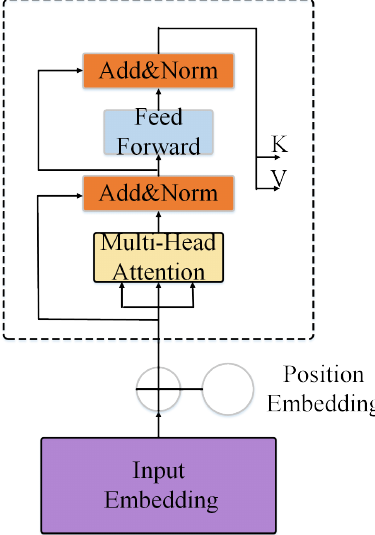
Figure 3. Architecture of the